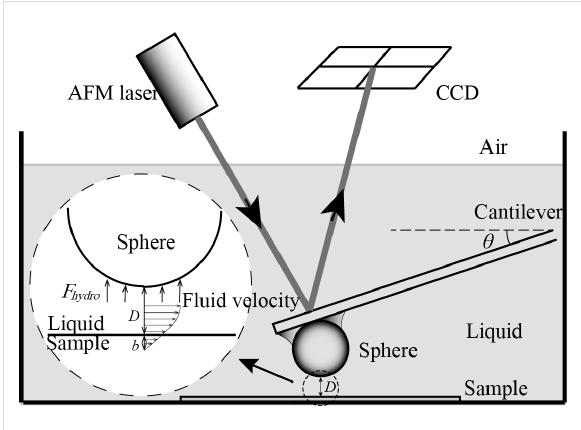
Figure 3: Schematic illustration of a slip-length measurement by using a colloidal AFM probe in contact mode. With the approach of the sphere towards the sample, the liquid is set into fluid flow. The arrows above and below the solid–liquid interface represent magnitude and direction for fluid flow with boundary slip. The definition of slip length b characterizes the degree of boundary slip at the solid–liquid interface, and can be obtained by the hydrodynamic force on the cantilever detected with